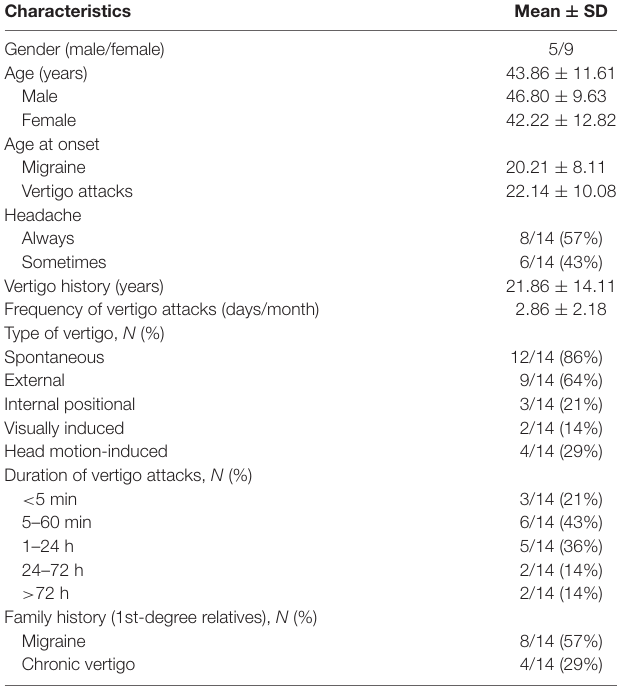
TABLE 1 | Clinical characteristics of patients with vestibular migraine (VM).